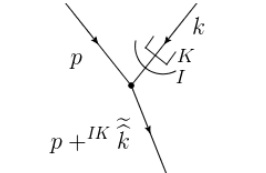
(cid:22) (cid:0) (cid:1) k (cid:1) (cid:12) ( (cid:12) K (cid:1) (cid:12) I ) (cid:12) . K I